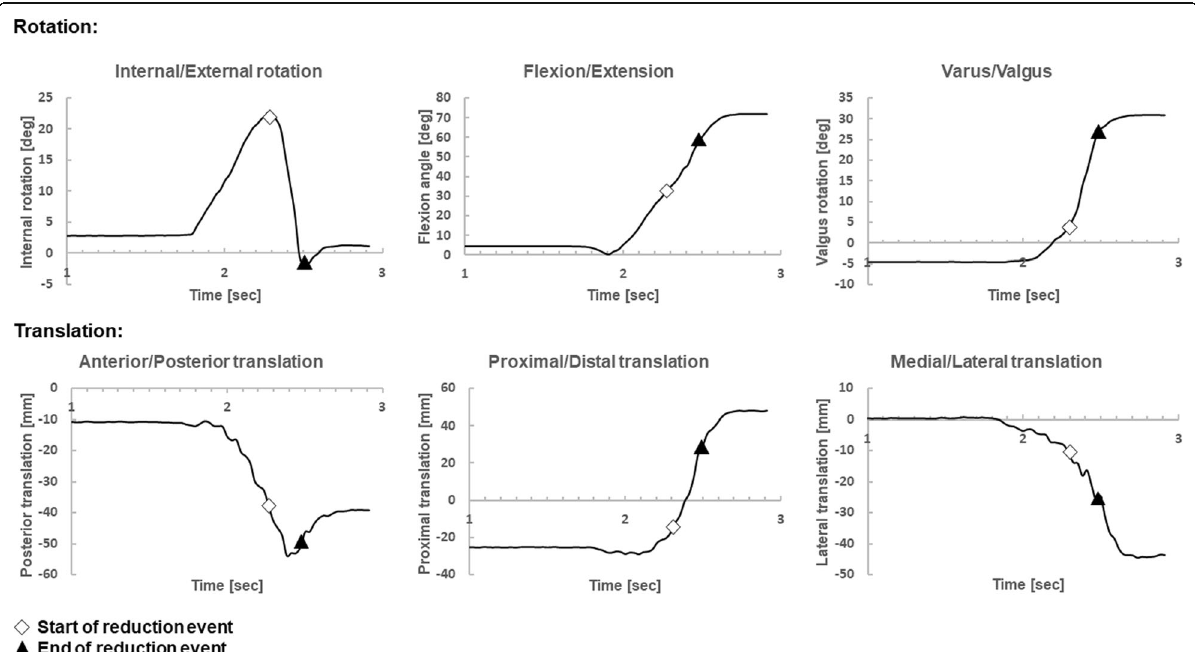
Fig. 2 A typical set of six degree of freedom kinematics recorded while the pivot shift test is performed by an experienced senior orthopaedic surgeon. The top row shows rotational DOF as a function of time. The bottom row shows translational DOF as a function of time. The start of the reduction event is labelled with a white rhombus, the end of the reduction event is labelled with a black triangle